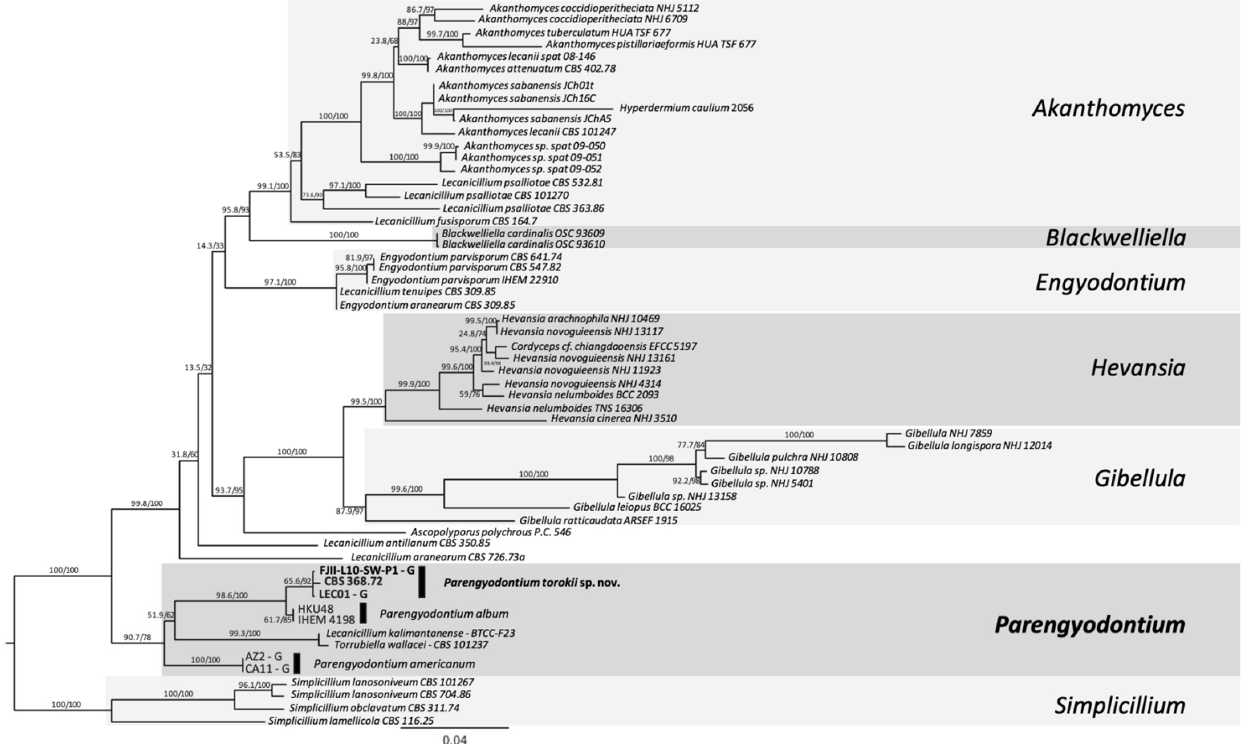
Figure 3. Multi Locus Sequence Typing (MLST) of Parengyodontium torokii . Gene sequences from the ITS region rRNA gene, D1/D2 domain of large subunit (LSU) rRNA gene, small subunit (SSU) rRNA gene, RNA polymerase II ( RPB1 and RPB2 ), and translation elongation factor 1- α ( TEF1 ) were used to investigate phylogenetic placement of the FJII-L10-SW-P1 among the main Cordycipitaceae groups. We used 59 taxa and 4617 nucleotide sites to build up a Maximum Likelihood tree on the IQTREE2 software. The branches are proportional to the number of mutations and 1000 ultrafast bootstraps and SH-like approximate likelihood ratio test (aLRT) was used to test branch support and added to each corresponding branch of the tree. The tree was rooted with the Simplicillium